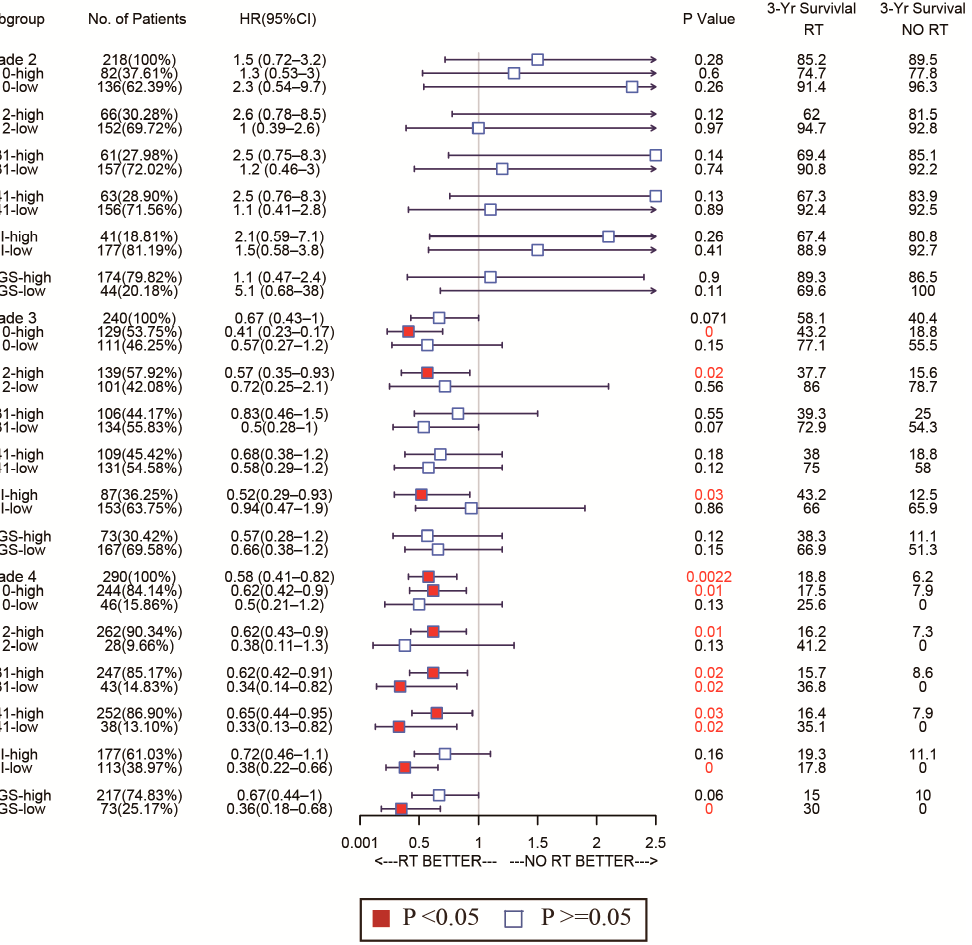
Figure 9. Forest plots to test the sensitivity of the selected markers for different WHO stages in the CGGA cohort.